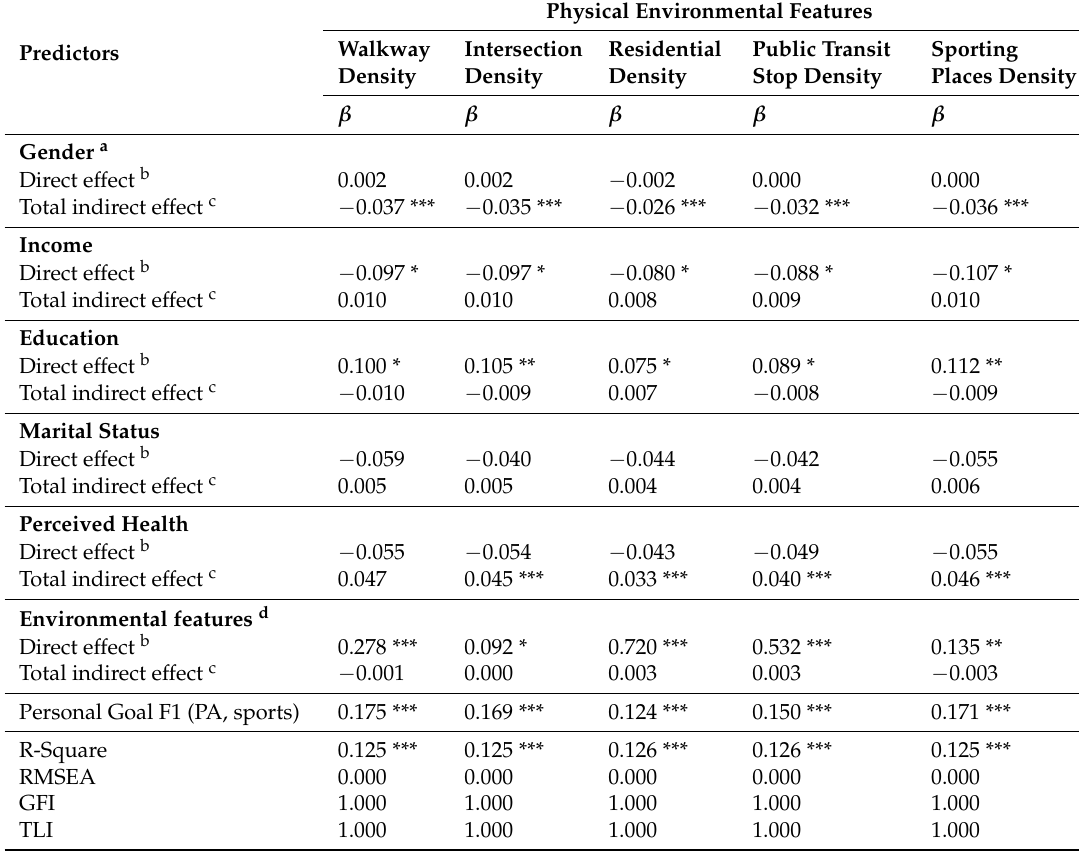
Table 4. The standardized model results for direct and total indirect effects of predictors on walking via PA and sports goal